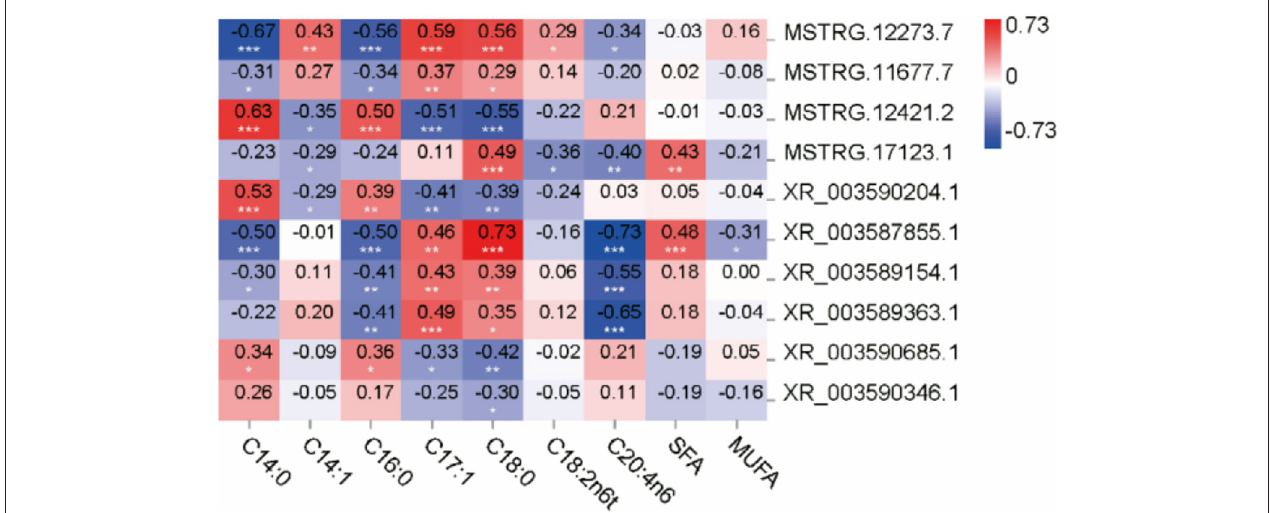
FIGURE 9 | Pearson correlations between expression of lncRNAs and content of fatty acids in the muscle of Tibetan sheep. *Correlation is significant at P < 0.05, **correlation is significant at P < 0.01, and ***correlation is significant at P < 0.001.